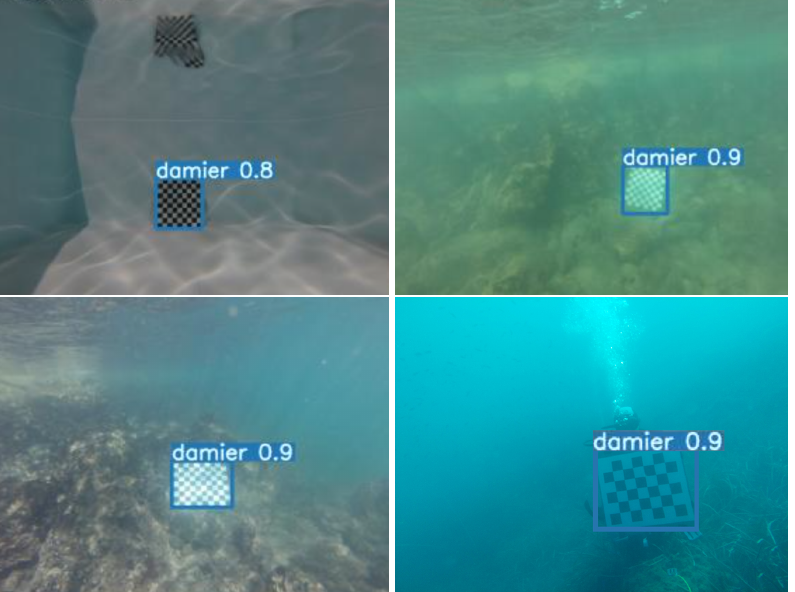
Figure 4. Four examples of bounding boxes detected by YOLO that represent chessboards in underwater